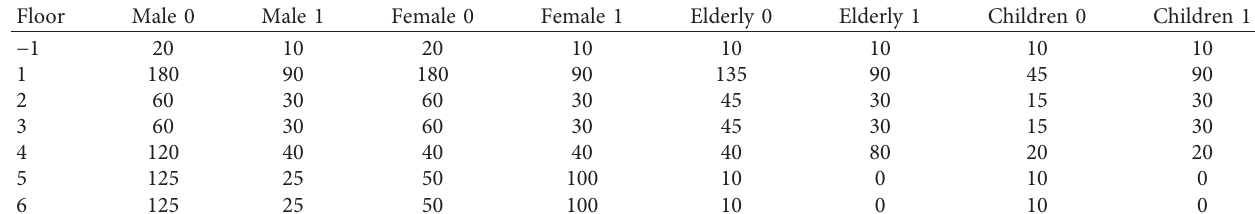
Table 18: Distribution of pedestrians on each floor.